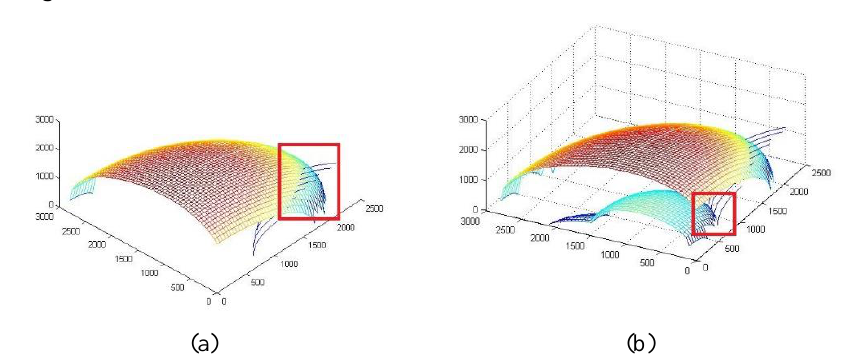
Fig. 11. An example of the intersection of welds bottoms with petal division with the working area of the